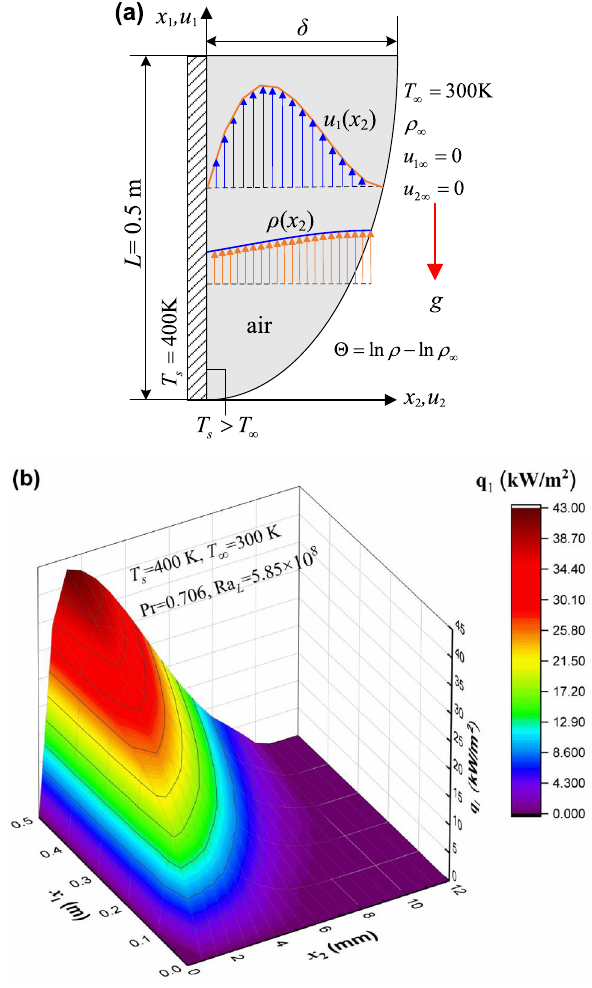
Figure 4. The spatial distributions of the heat flux vector of natural convection predicted by the present theory. ( a ) The steady laminar flowing air along the vertical flat plate surface under the constant surface temperature T s . Assuming the thickness of velocity boundary layer δ is the same as the thermal boundary layer. ( b ) The 3D theoretical profile of the streamwise convection heat flux q 1 and that of ( c ) the wall-normal convection heat flux q 2 along the plate length direction and across the fluid thickness direction, respectively, according to Eq. (36). Ra L is the Rayleigh number at x 1 = L , whose value is controlled to be less than 10 9 to ensure the laminar flow obtained 21,22 . ( d ) The 2D vector map and contour lines of the resultant heat flux vector q for free convection obtained from the present theory. It is the resultant of its vectorial components q 1 and q 2 , which is dominated by the main-stream-wise convective heat flux component q 1